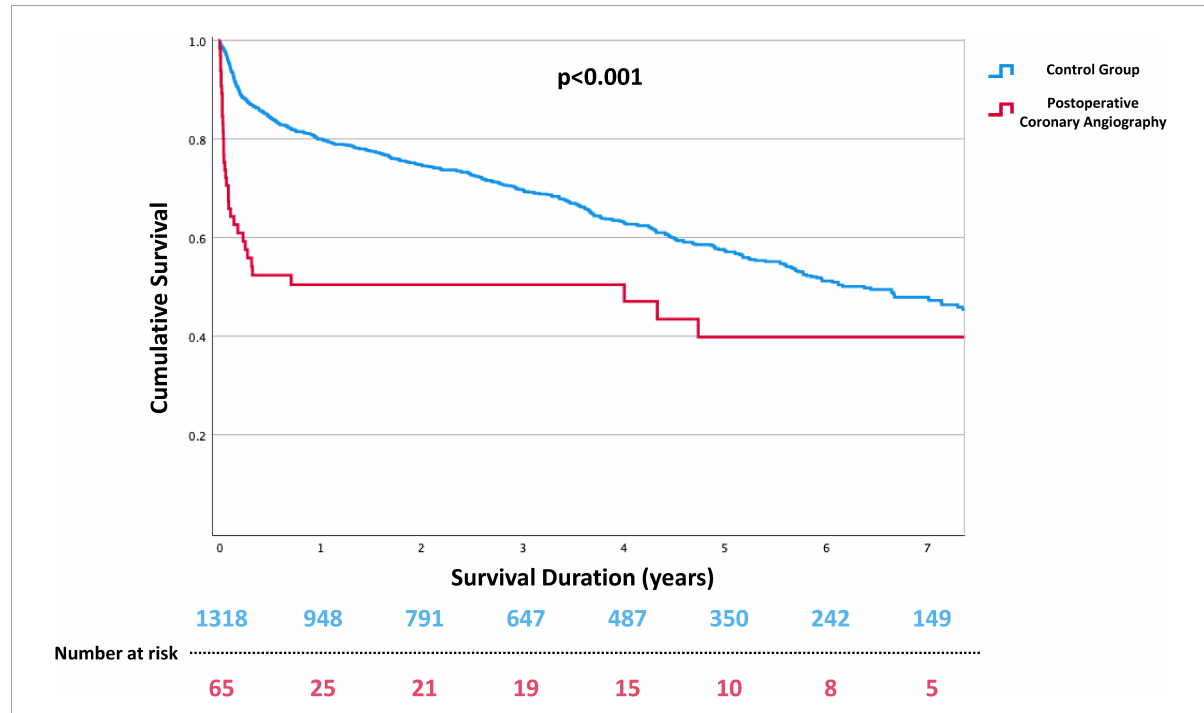
FIGURE3 Kaplan–Meyer curves for long-term all-cause mortality after tricuspid valve surgery. Patients requiring immediate post-operative coronary angiography due to suspected myocardial ischemia were shown to have a worse outcome in intermediate-term follow up.